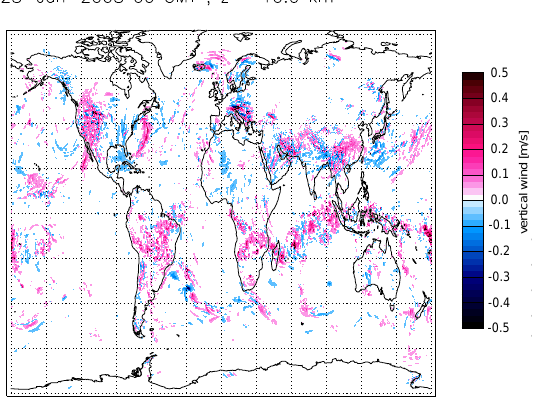
Figure 9. Vertical winds for 28 January 2008, 10km altitude; dark blue indicates values of − 0.5ms − 1 or less, dark red indicates val- Fig. 9. Vertical winds for 28 January 2008, 10 km altitude; dark blue indicates values of -0.5 ms − 1 or less, dark ues of 0.5ms − 1 or red indicates values of 0.5 ms − 1 or more.